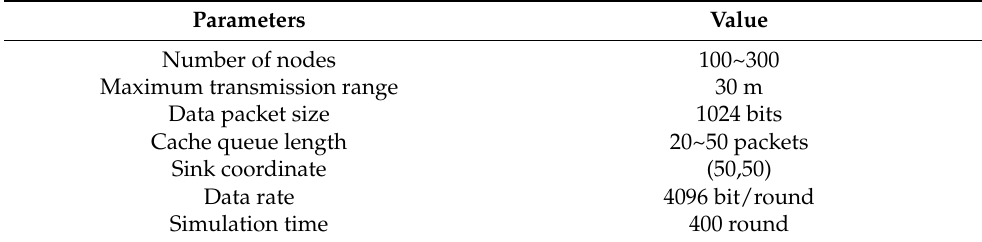
Table 1. The simulation parameter settings.